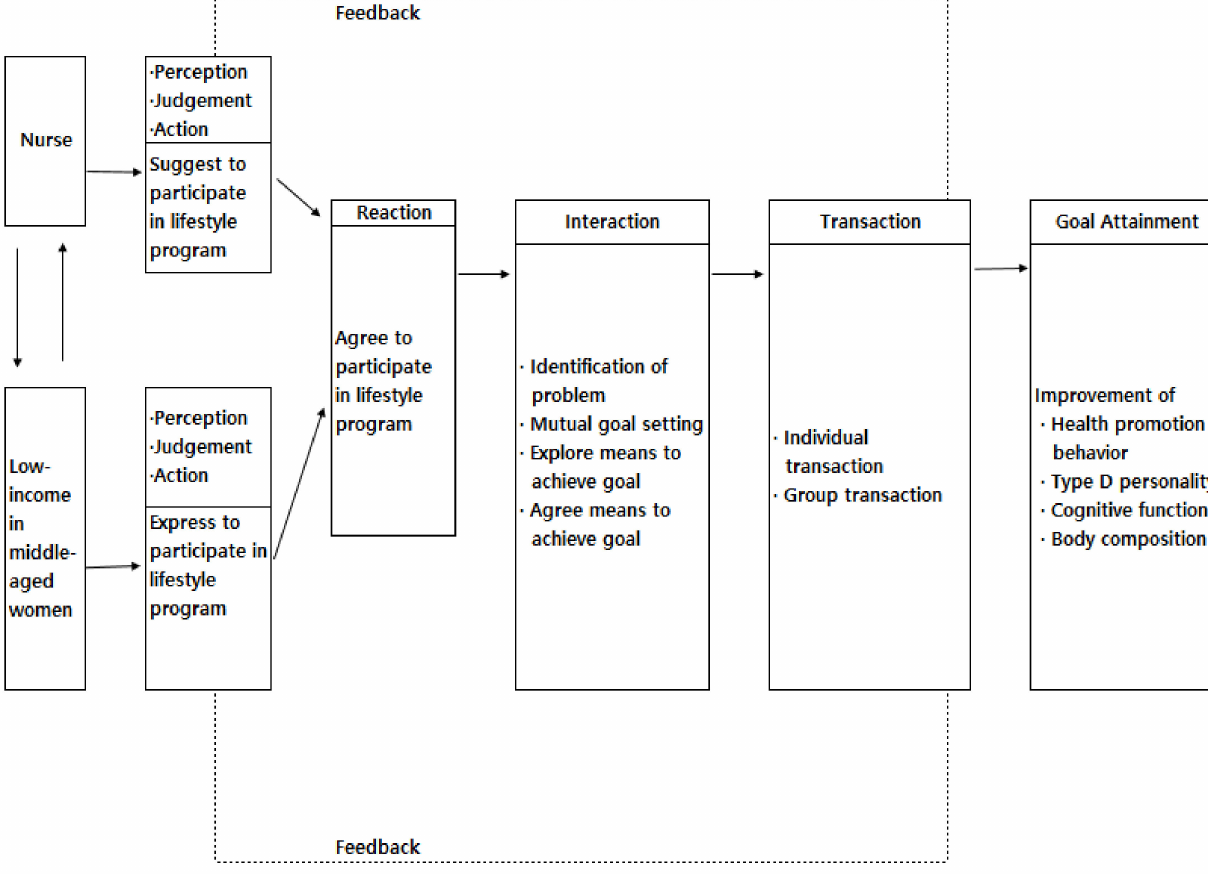
Figure 2. Conceptual